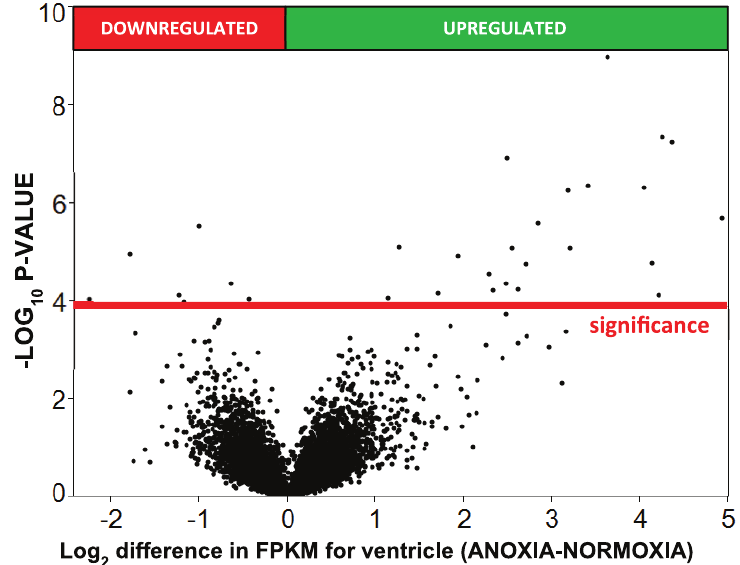
Fig 2. Volcano-plot showing transcriptomic changes in ventricle after 24 hours of anoxia at 19°C. The y-axis represents the − log10 of the P-value while the x-axis represents the log2 differential expression for each gene. Differential expression was determined using ANOVA assuming a log-normal distribution. The red reference line represents the significance threshold calculated from the FPR multiple testing correction.